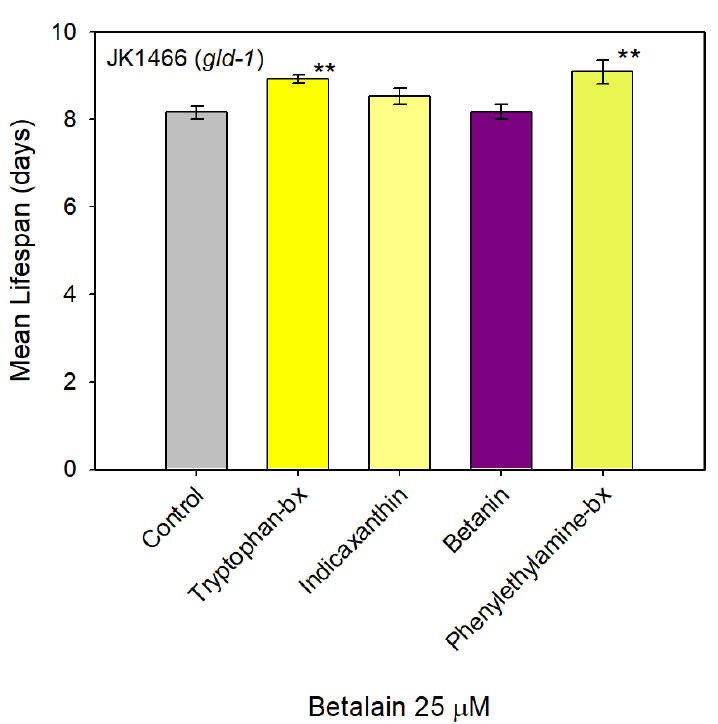
Figure 5. Mean lifespan of C. elegans JK1466 strain treated with pure betalains. Mean lifespan (mean ± SE) of C. elegans gld-1 mutants which were treated with tryptophan-betaxanthin ( n = 62), indicaxanthin ( n = 60), betanin ( n = 52), and phenylethylamine-betaxanthin ( n = 50) and without treatment (control) ( n = 64). ** indicated p ≤